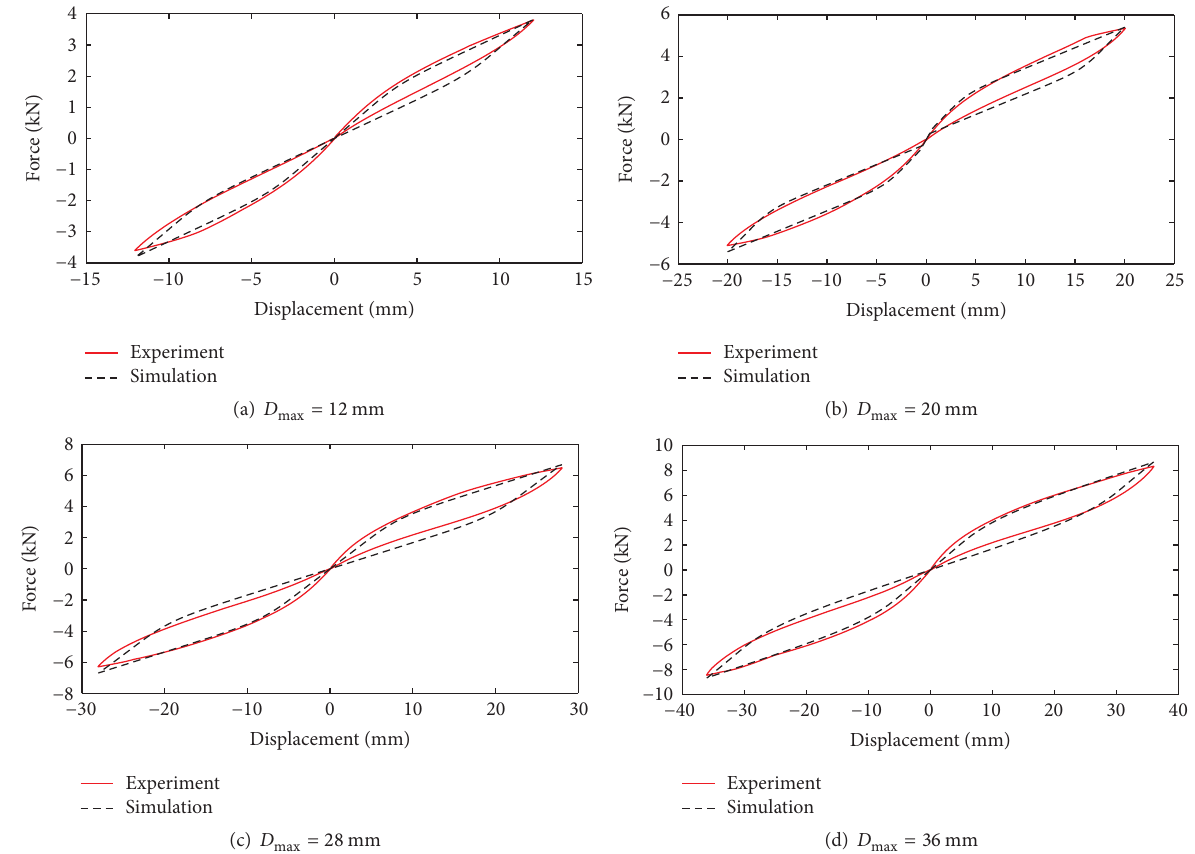
Figure 7: Experimental and numerical hysteretic curves of SMA spring.